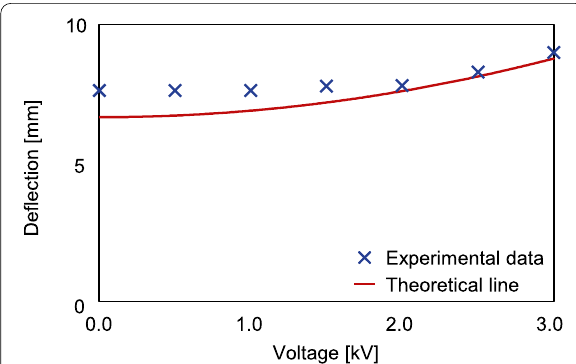
Fig. 7 Maximum deflection δ (0) acquired by experiments and theoretical calculations with varies electric voltage 0 kV to 3.0